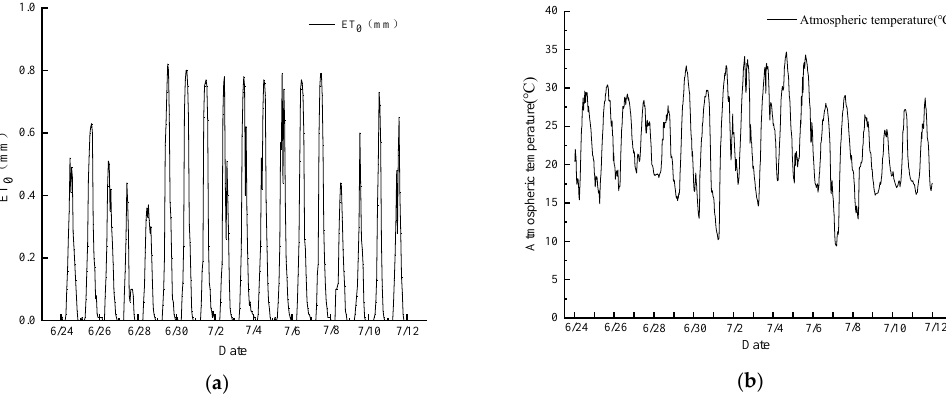
Figure 4. Variation of ET 0 and atmospheric temperature during the experiment. ( a ) Variation of ET 0 during the experiment; ( b ) Variation of atmospheric temperature during the experiment. Table 2. Rainfall and irrigation during the experiment.